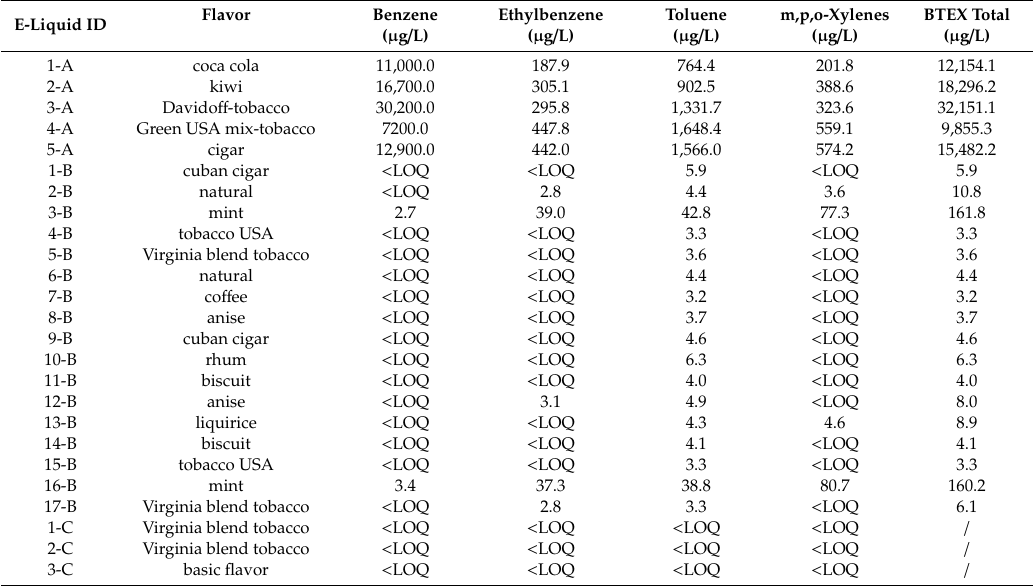
Table 2. Benzene, toluene, ethylbenzene and xylenes (BTEX) concentration (expressed in µ g / L) in the investigated